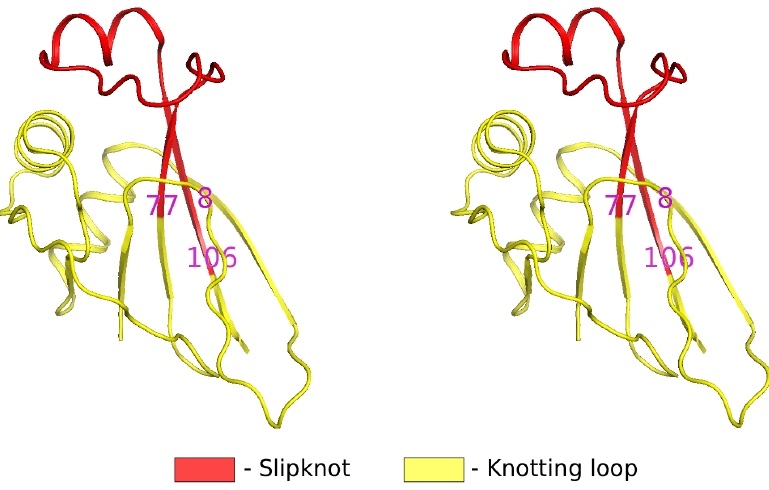
Fig 1. A cross-eye 3D view of the AFV3-109 (PDB code 2J6B), the yellow knotting loop extends over residues 8-77 and the red threaded slipknot consists of residues